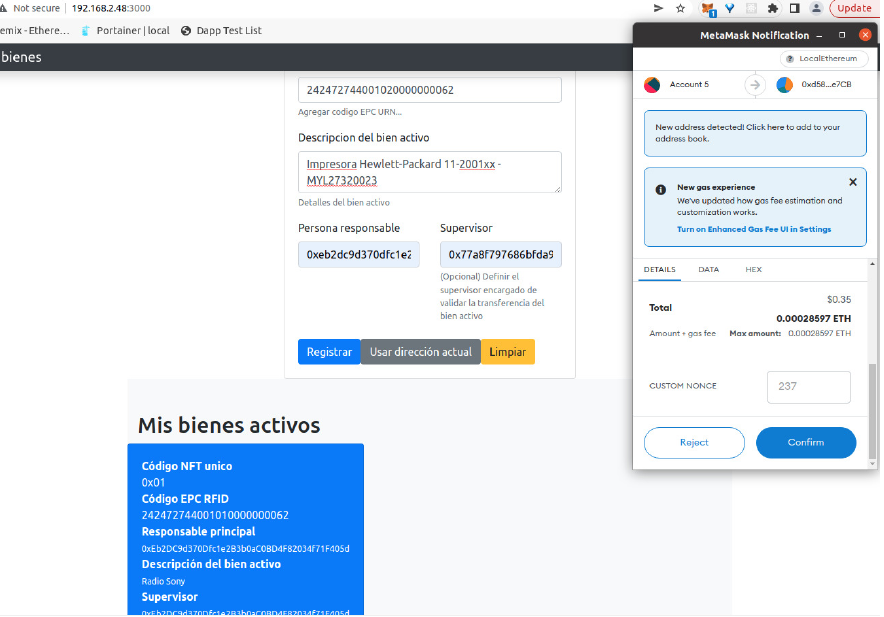
Figure 8. DAPP new asset registration form in Spanish, waiting for confirmation to operate using MetaMask, with a cost of ETH 0.00028597.